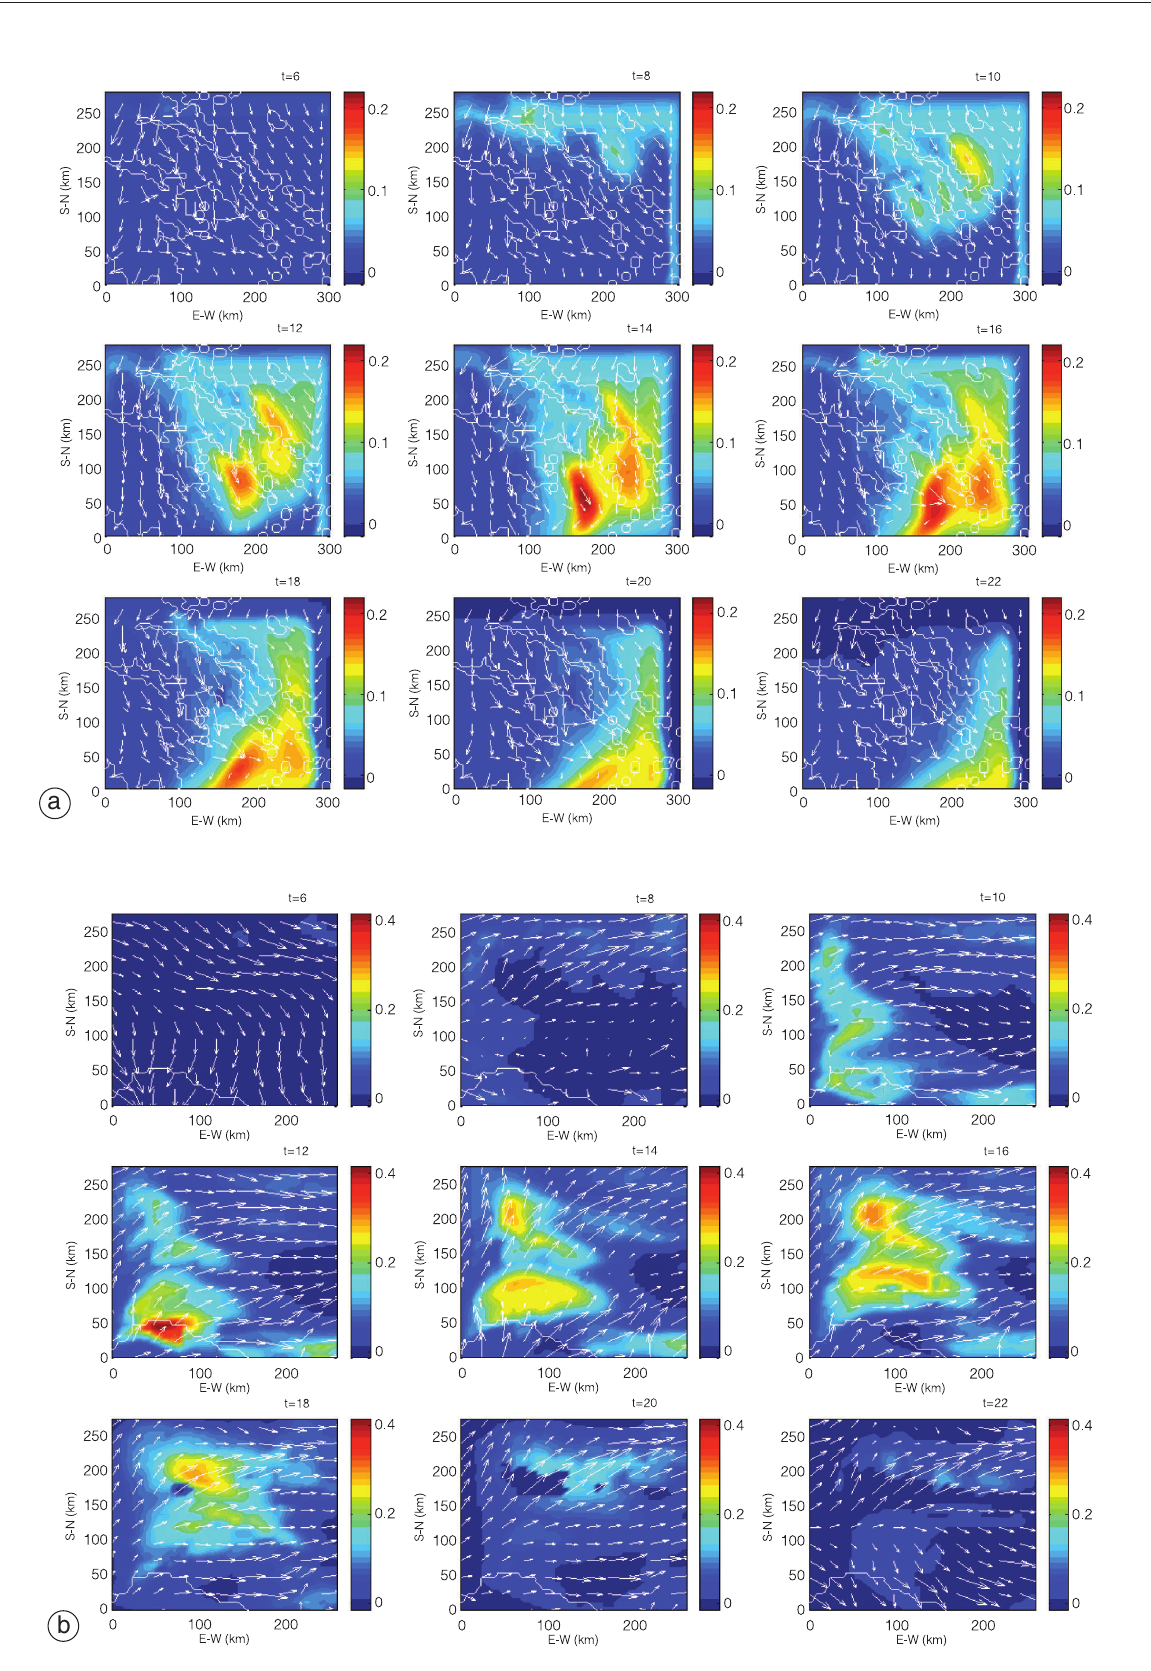
a O3 VOC for the domain of: a) Athens; b) Milan. Fig. 3a,b. Evolution of S 1